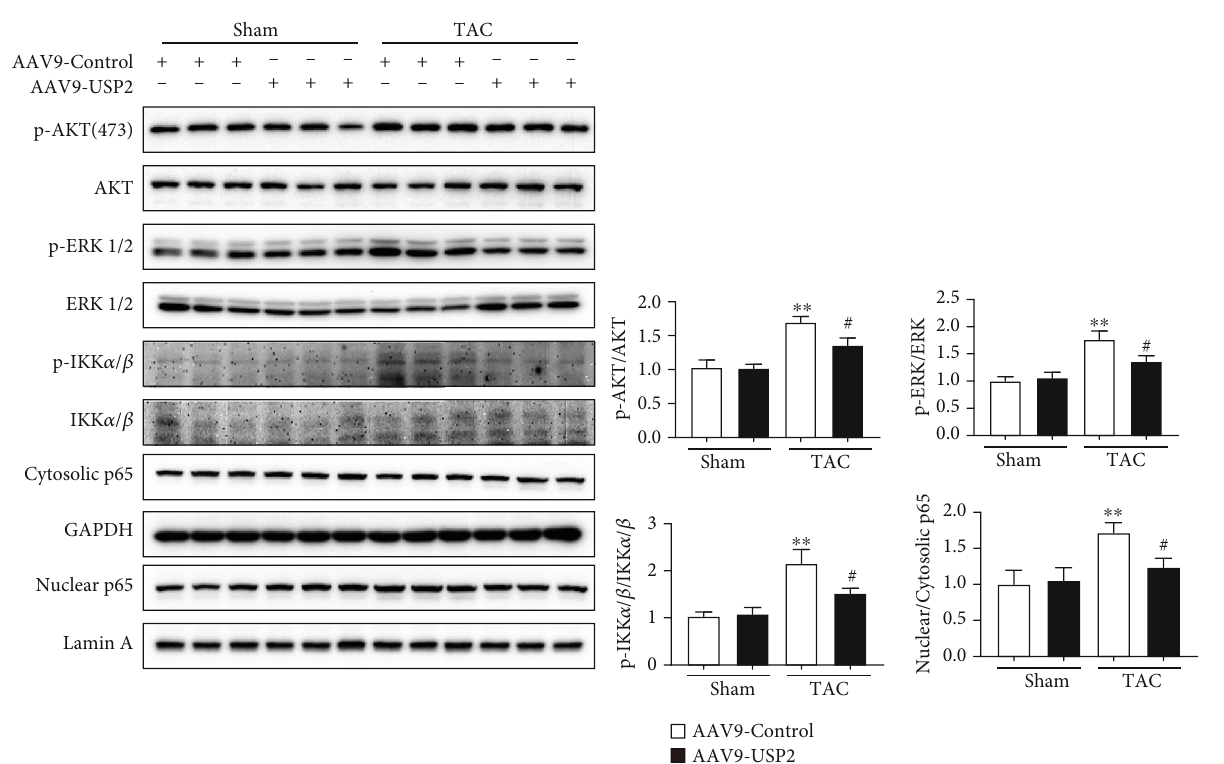
Figure 6: Overexpression of USP2 on signaling pathways of AKT, p-ERK1/2, and p-IKK α / β . Representative Western blot analyses of USP2, p-AKT, AKT, p-ERK1/2, ERK1/2, p-IKK α / β , IKK α / β , nuclear p65, cytosolic p65, Lamin A, and GAPDH in heart tissues from AAV9-Control or AAV9-USP2-treated mice following sham or TAC. All values are presented as the relative value of the sham (AAV9-Control) value. ∗ P < 0 : 05 and ∗∗ P < 0 : 01 (AAV9-Control plus TAC vs. AAV9-Control plus sham); # P < 0 : 05 and ## P < 0 : 01 (AAV9-Control plus TAC vs . AAV9-USP2 plus TAC); $$ P < 0 : 01 (AAV9-Control plus sham vs. AAV9-USP2 plus sham). n = 3